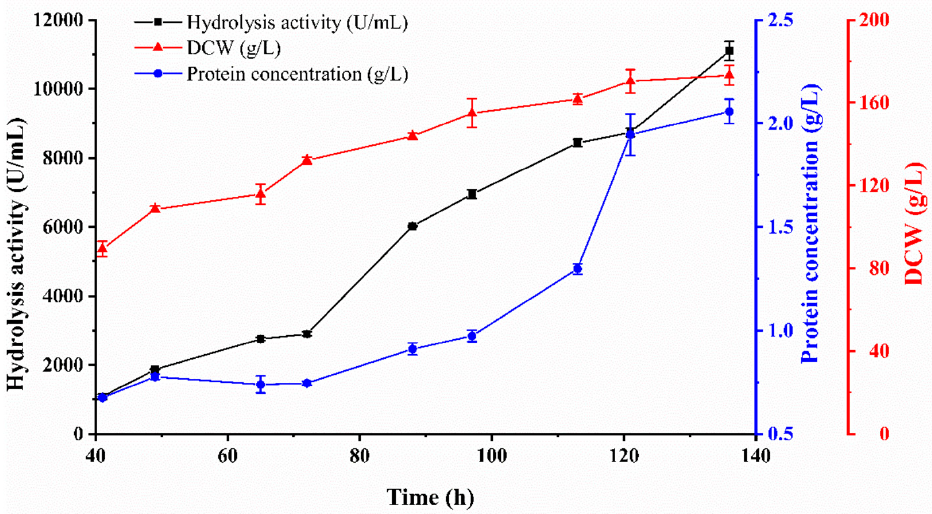
Figure 3. Time course of lipase hydrolysis activity ( ■ filled square), DCW of biomass (SCP) ( ▲ filled triangle), and total protein concentration ( ● filled circle) during fed-batch fermentation of the best engineered Y. lipolytica strain in a 30 L fermenter with 15 L initial modified FM22 medium. Raw glycerol was used as the sole carbon source.